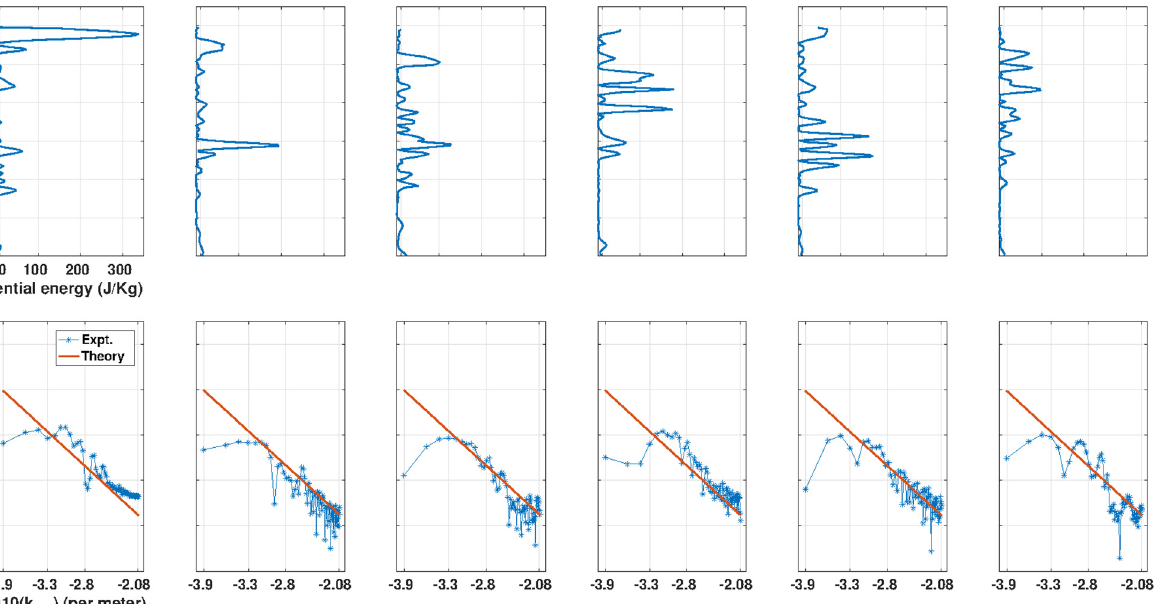
Figure 8. potential energy of the gravity wave ( top panels ) versus altitude and logarithm of theo- retical ( red line ) and experimental ( lines with asterisks ) power spectral density normalized tem- perature perturbation versus the logarithm of the vertical wave number of atmospheric gravity wave ( bottom panels ) on 16 October 2011.